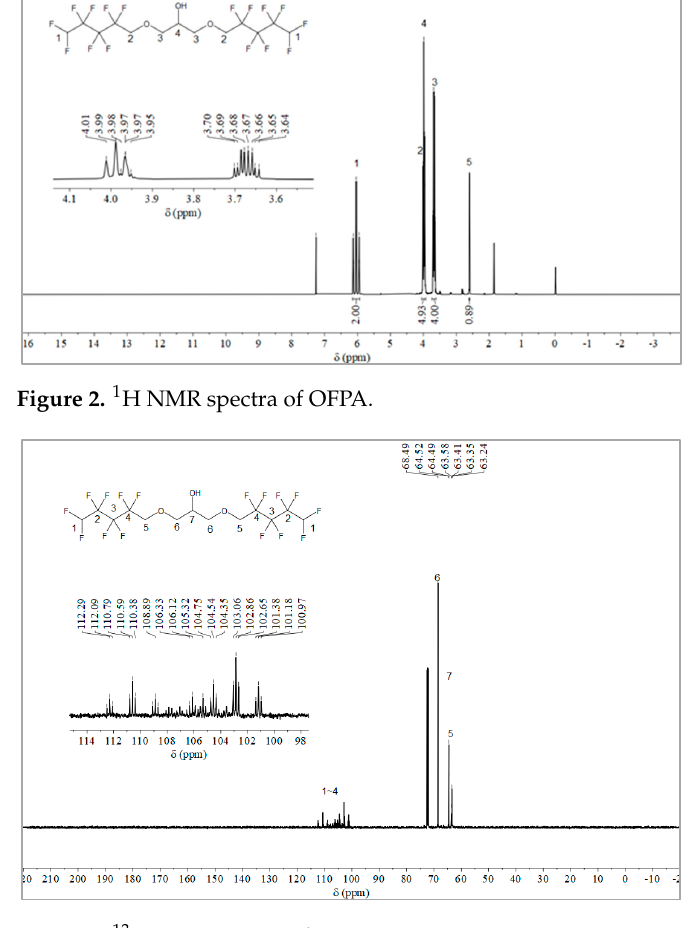
Figure 3. 13 C NMR spectra of OFPA.